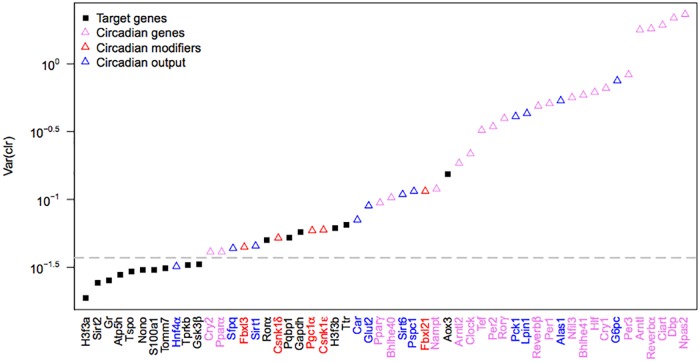
Analysis of the variance of expression of the candidate genes using Nanostring hybridization data.The variance of the clr of the expression level for each gene was calculated across all experimental conditions, i.e. eight different ages and twelve time points each in duplicate (N = 192). Genes are sorted from lowest to highest variance and the cut off to pass the assessment is indicated by a dashed line.